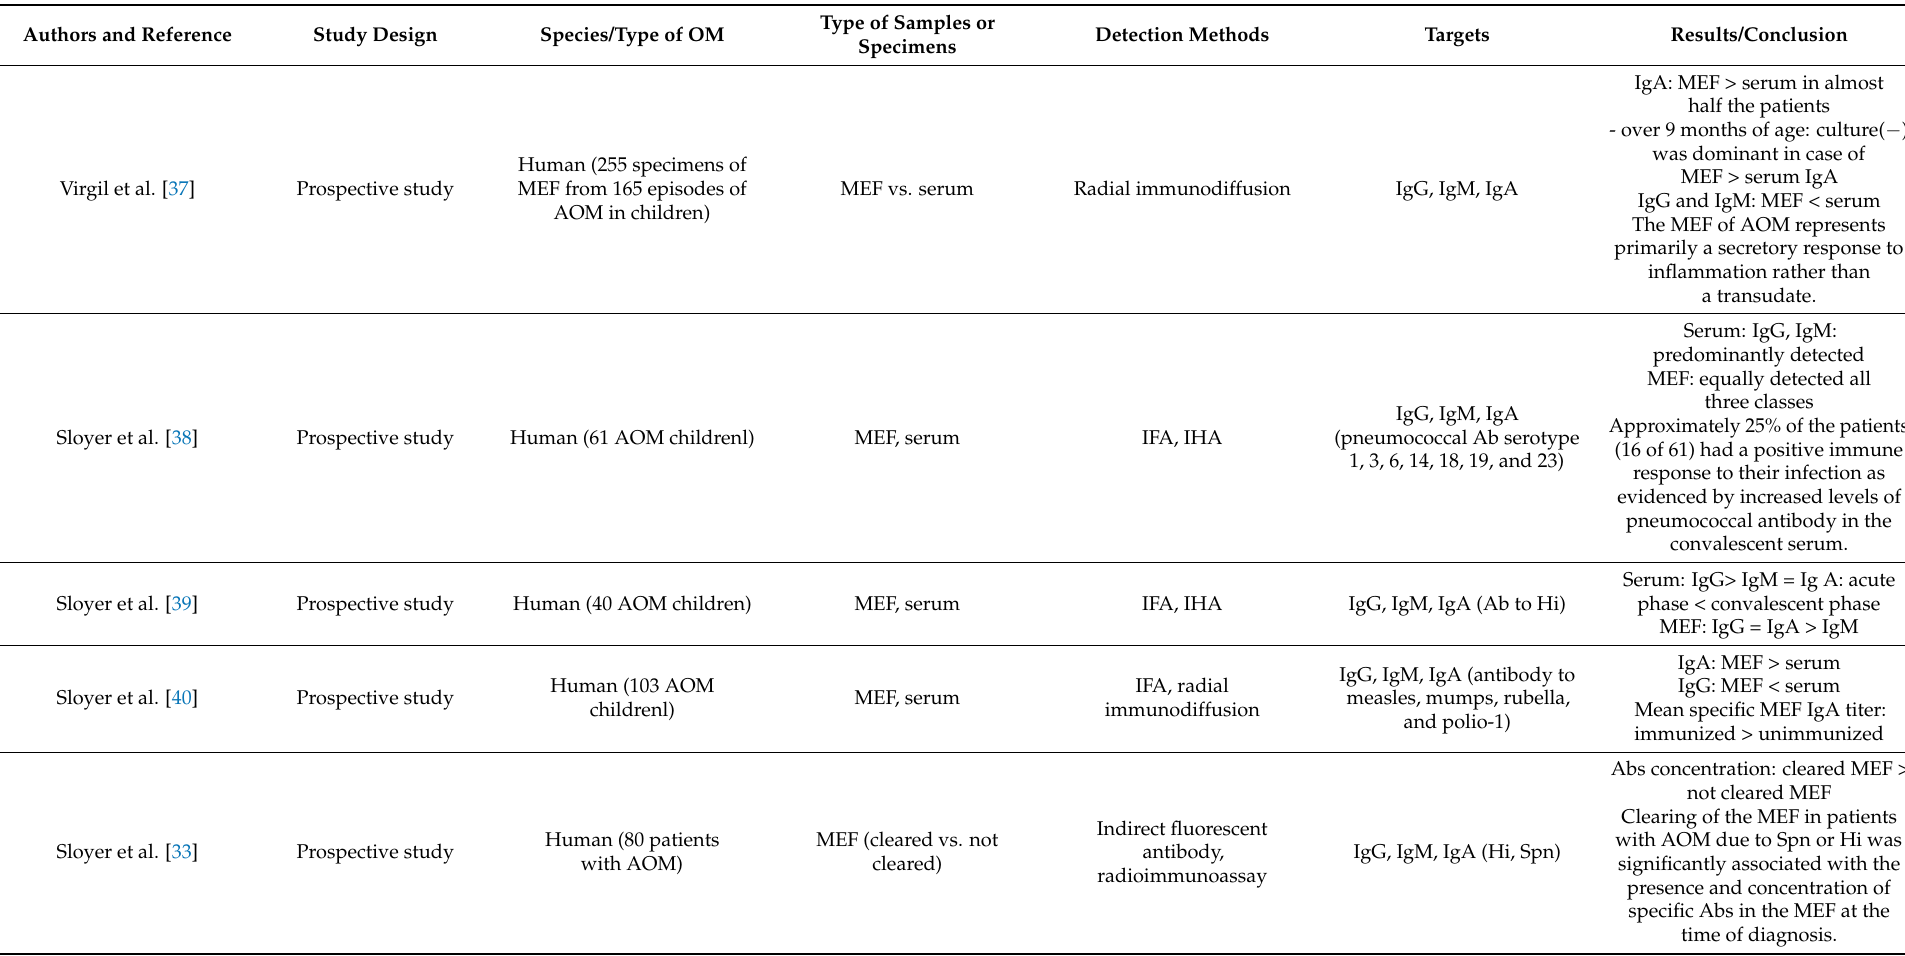
Table 1. Studies assessing the expression of antibodies in otitis